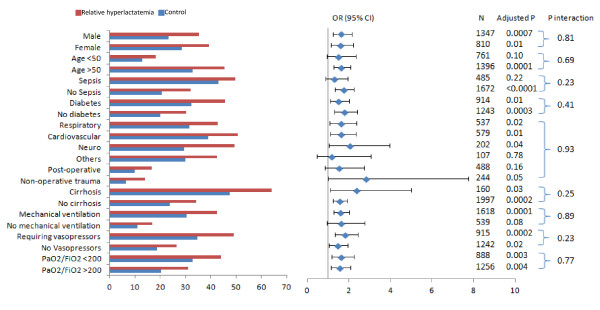
Crude mortality, adjusted odds ratios, confidence intervals, and P value for the test of interaction for the association between relative hyperlactatemia and hospital mortality in different subgroups.